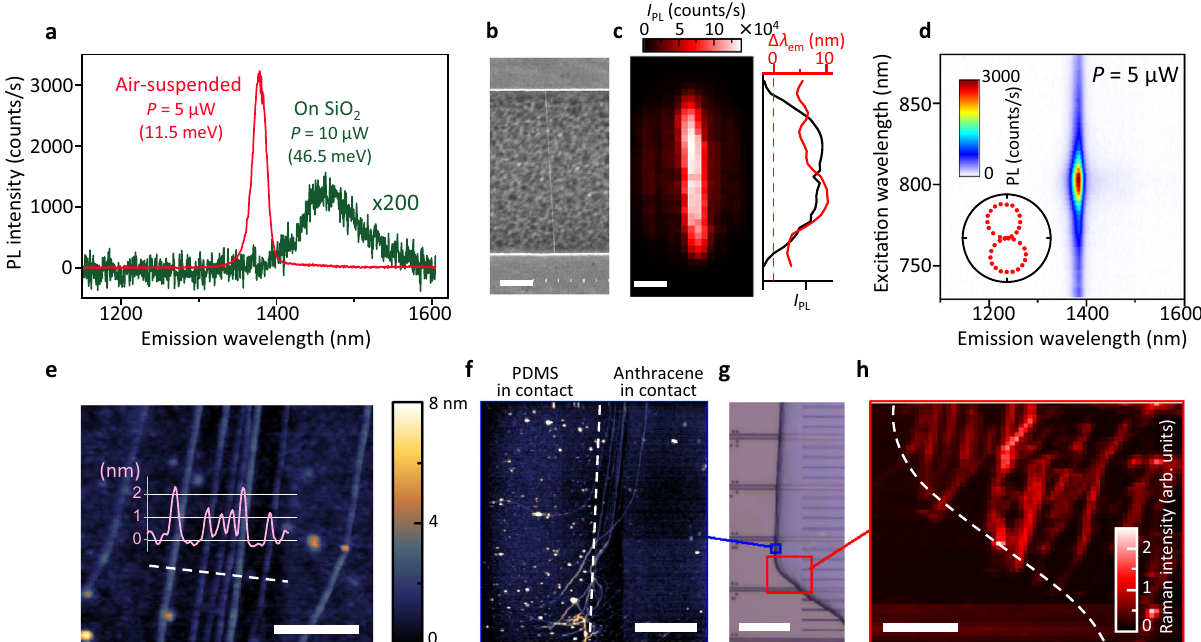
Fig. 2 Bright PL of a transferred CNT. a PL spectra of the CNT transferred from a quartz substrate. Red and green spectra are measured from the same CNT at an air-suspended region and at a region in contact with the SiO 2 surface, respectively. Numbers in parentheses represent the full width at half maximum. b SEM image of the suspended region and c the corresponding PL image at emision wavelength λ em of 1379 nm. Excitation power P = 5 μ W. The peak shift Δ λ em (red) from as-grown tubes 28 and integrated PL intensity I PL (black) along the tube axis are shown in the right panel. d PLE spectrum from which chirality is determined to be (9,8). Inset: polarization angle dependence of I PL . e , f AFM image of the aligned CNTs measured on the SiO 2 surface after sublimation of an anthracene crystal. In f , the left and right sides are in contact with PDMS and anthracene, respectively. g Optical image of the anthracene crystal with CNTs from quartz. h Raman mapping showing G-band intensity in the region outlined by a red box in g . Scale bars in b – c and e – h are 1, 1, 0.5, 2, 50, and 10 μ m,